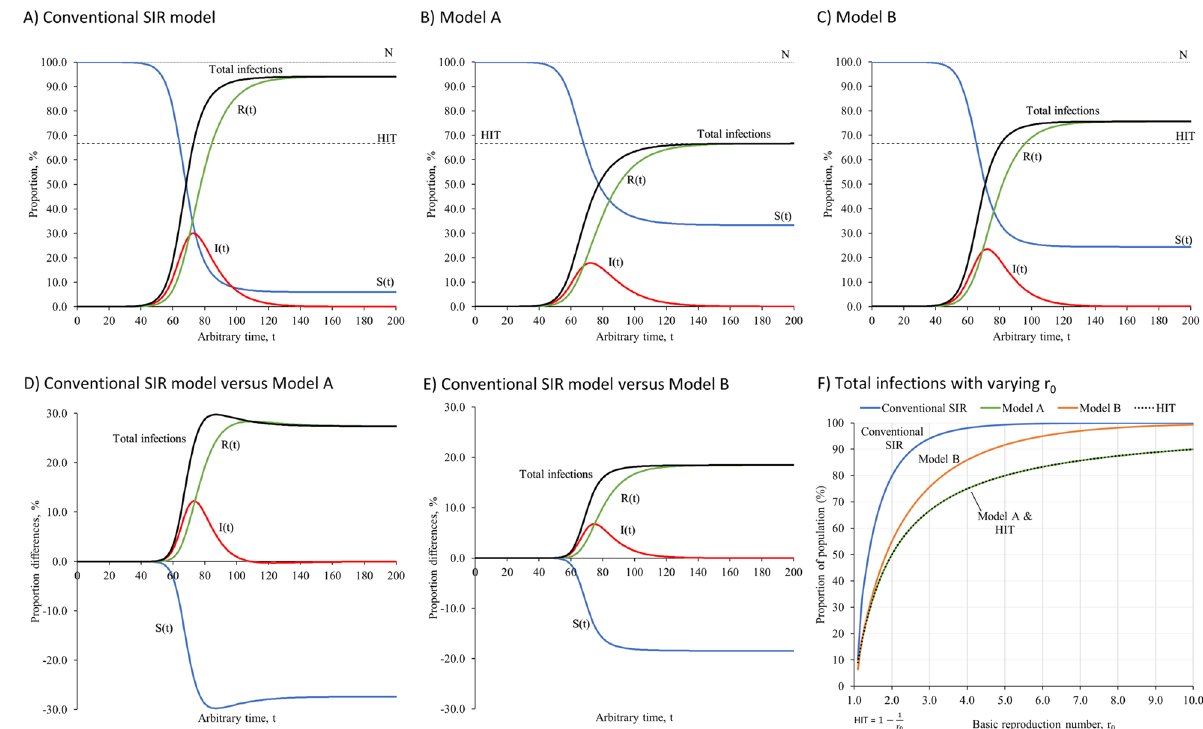
Figure 4. The transmission dynamics of infectious diseases with natural herd immunity. (A–C) presents the transmission dynamics of infectious diseases with herd immunity through infection simulated by the conventional SIR model, Model A and Model B. (D,E) presents the proportion differences between the conventional SIR model and Model A, and between the conventional SIR model and Model B. (F) presents the total infections generated by the conventional SIR model, Model A and Model B with varying r 0 . All data used to create the figures can be sourced at https:// github. com/ willi am81/ newSIR. herd- immun ity. model.